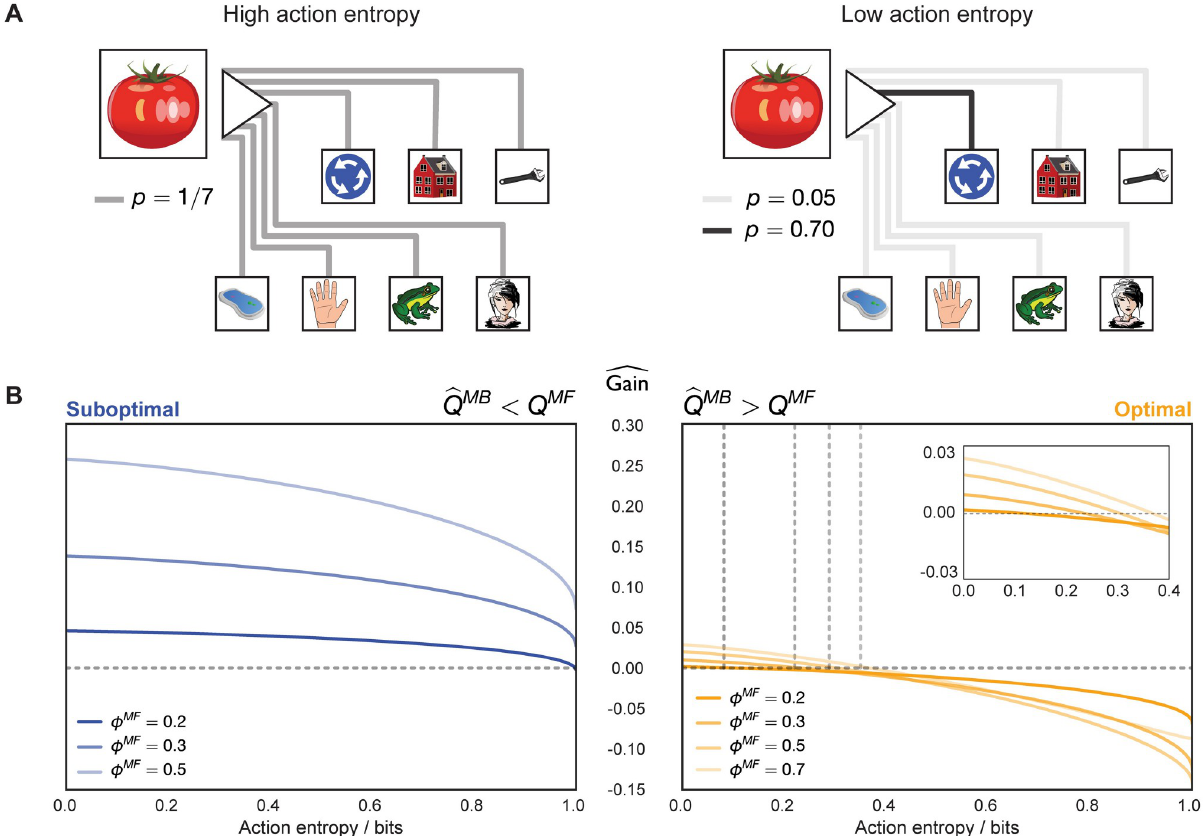
Fig 5. Action entropy limits estimated gain. (A) Left: under high action entropy, the distribution over the potential states to which the agent can transition given the current state and a chosen action is close to uniform. Right: under low action entropy, the agent is more certain about the state to which a chosen action will transition it. (B) Left: for an objectively sub-optimal action, the gain is positive throughout most action entropy values. Right: for an objectively optimal action, the gain becomes positive only when the state-transition model is sufficiently accurate. With heavier MF forgetting (higher ϕ MF ), however, the intercept shifts such that the agent is able to benefit from a less accurate model (grey dashed lines show the x- and y- intercepts). The inset magnifies the estimated gain for the optimal action. Moreover, note how the magnitude of the estimated gain for an objectively optimal action is lower than that of a sub-optimal one, which is additionally influenced by the asymmetry of MF forgetting and on-line